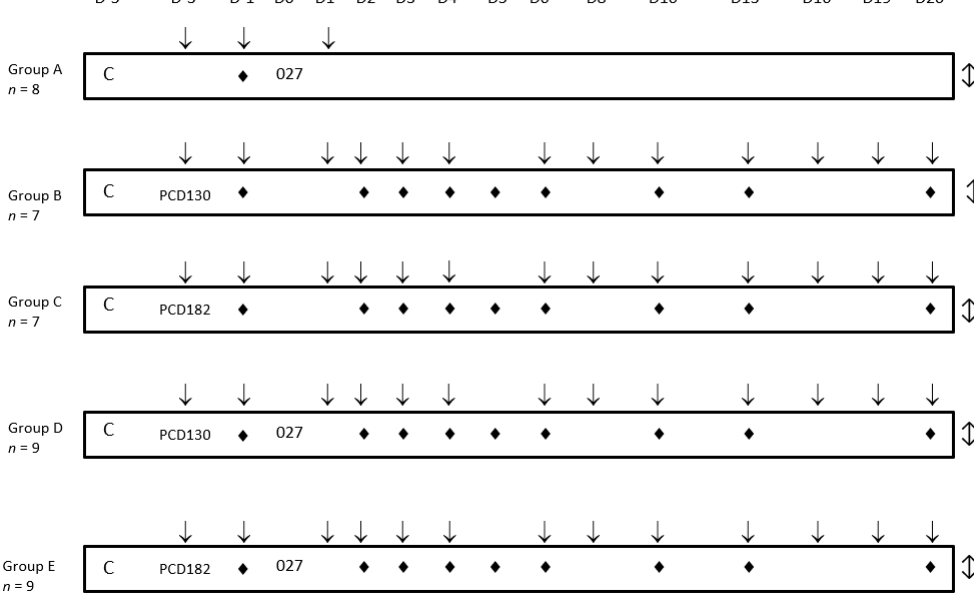
Figure 1. Experimental design of the In vivo study. C: Clindamycin administration; (cid:7) : stool sampling; ↓ : weighing; (cid:108) : euthanasia of surviving